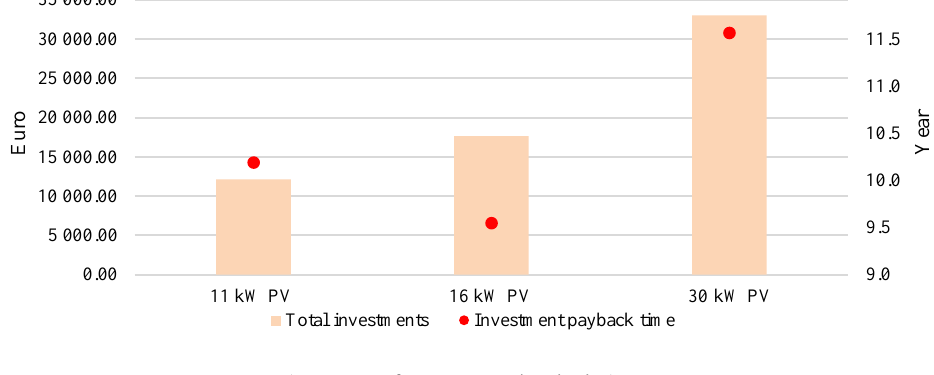
Fig. 3. Costs of PV system and payback